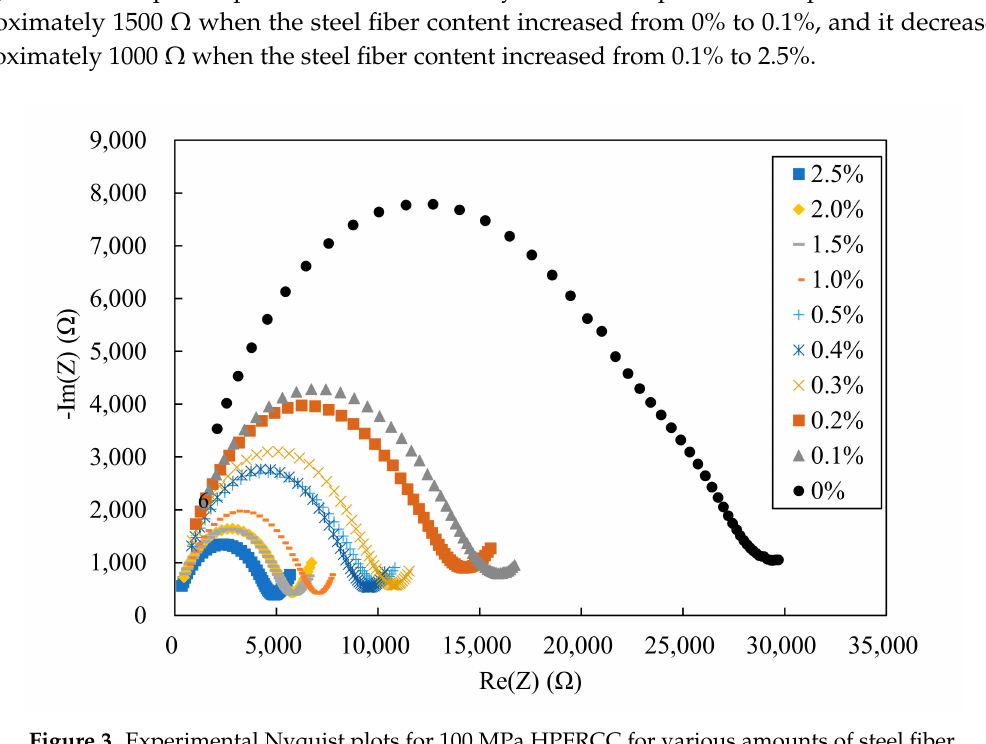
Figure 3. Experimental Nyquist plots for 100 MPa HPFRCC for various amounts of steel